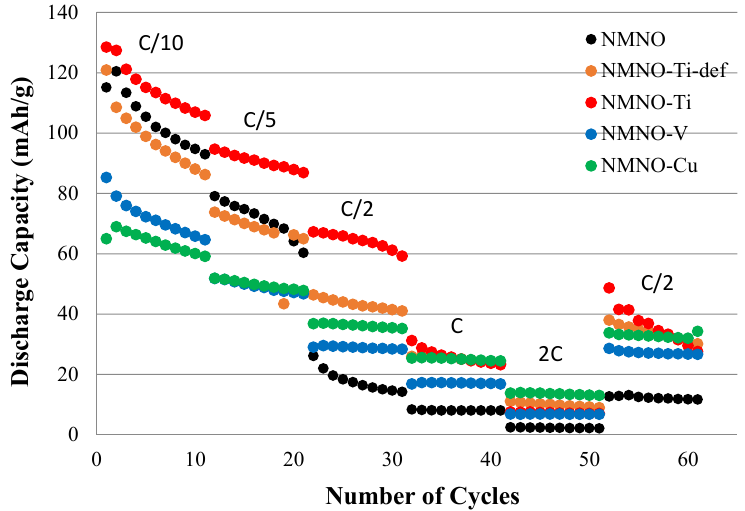
Figure 7. Discharge capacity values of all the samples at different C-rate values. NMNO has comparable performances at C/10 and C/5, which drop at the higher C-rates, probably due to the too slow semi-infinite linear diffusion kinetics associated with phase transitions, also explaining the unsatisfactory results of